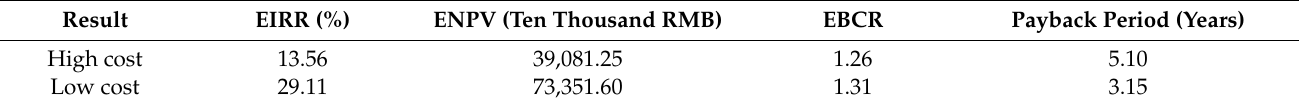
Table 7. National economic evaluation result.